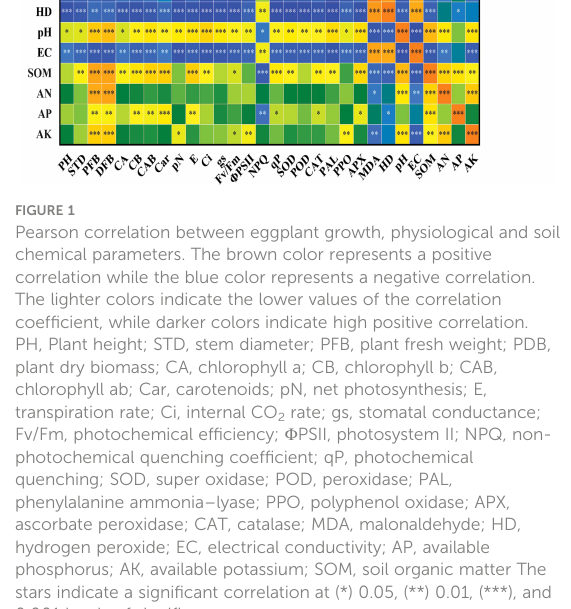
(Table 6), including water holding capacity and aeration, and ultimately increases plant growth attributes like root growth and nutrient foraging. In the wheat-peanut crop rotation system, increased nitrogen uptake and allocation resulted in greater chlorophyll synthesis and photosynthesis rate (Liu et al., 2019). Moreover, increased pigment synthesis and photosynthesis in the crop rotation system were linked with improved PSII functioning.